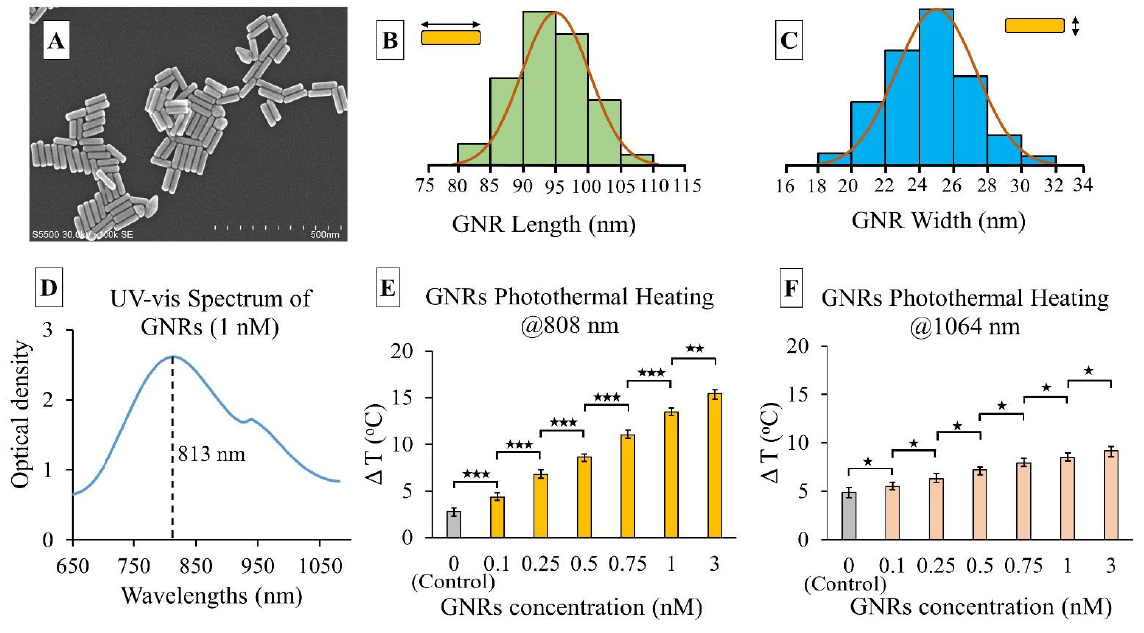
Figure 5. ( A ) SEM image of the GNRs; representation of GNRs’ size-frequency histogram of n = 100 distribution as determined from SEM image analysis: ( B ) GNR length (95.2 ± 4.7 nm), ( C ) GNR width (24.8 ± 1.5 nm), average aspect ratio (length/width): 3.83; ( D ) UV-vis absorption spectrum of a sample GNR solution (1 nM concentration) with an absorption peak at 813 nm wavelength; temperature rise ( ∆ T) vs. GNR concentration graph when exposed to 30 mW · mm − 2 beam at ( E ) 808 nm, and ( F ) 1064 nm laser wavelengths. The error bars represent mean ± 1 σ (standard deviation) for n = 5 trials. Student’s T-test showed the statistical significance between two consecutive GNRs’ concentrations and control (distilled water) which are represented by ★ symbol. ★ = p < 0.05, ★★ = p < 0.01, and ★★★ = p < 0.001.